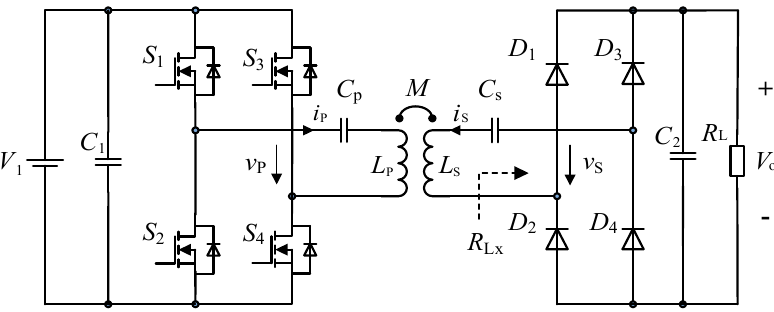
Figure 1. Schemes follow the same formatting.